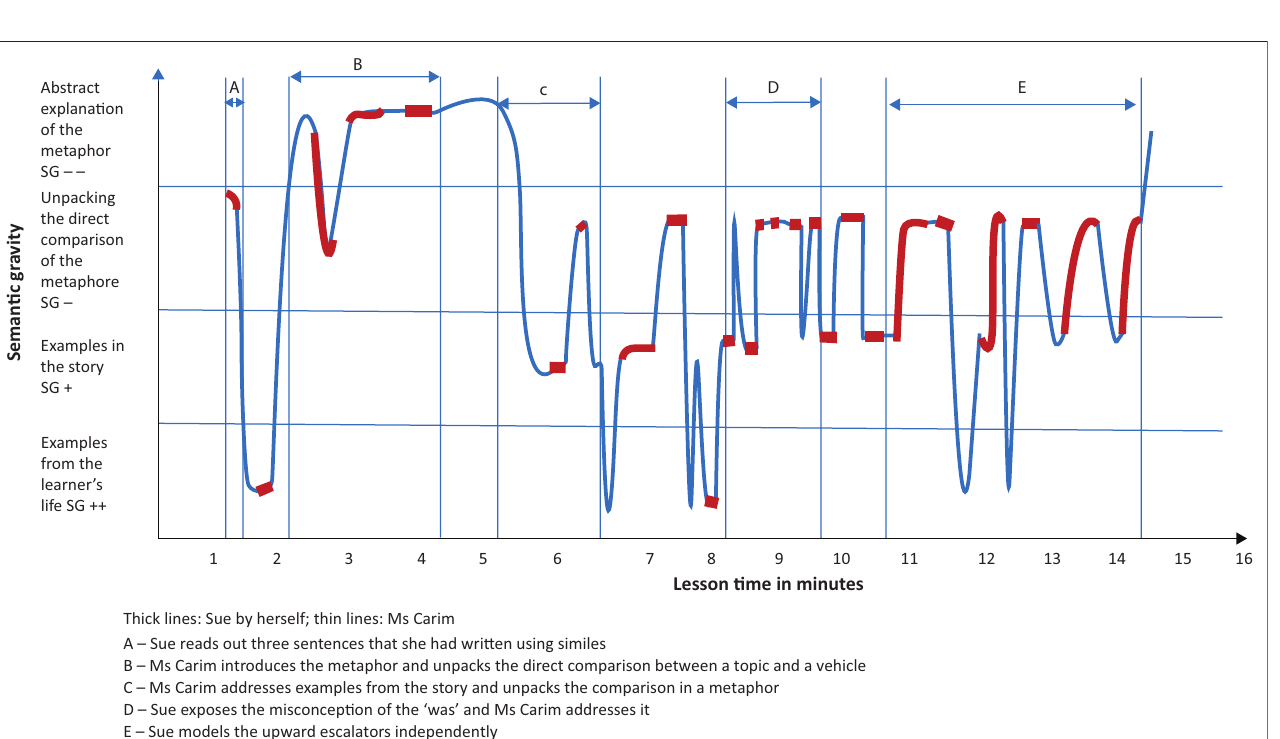
FIGURE 4: Semantic profile for Sue’s